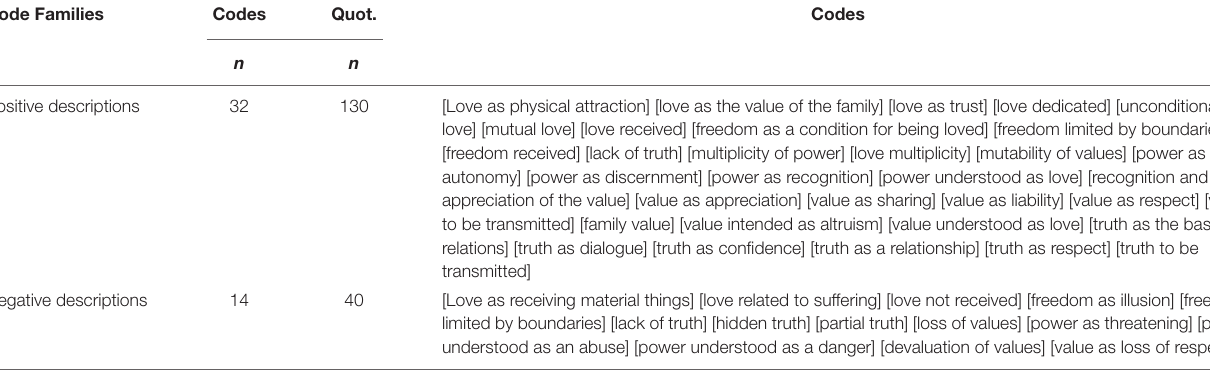
TABLE 2 | Code Families in the first Hermeneutic Unit (HU1): positive and negative descriptions of Themes. Code Families Codes Quot.